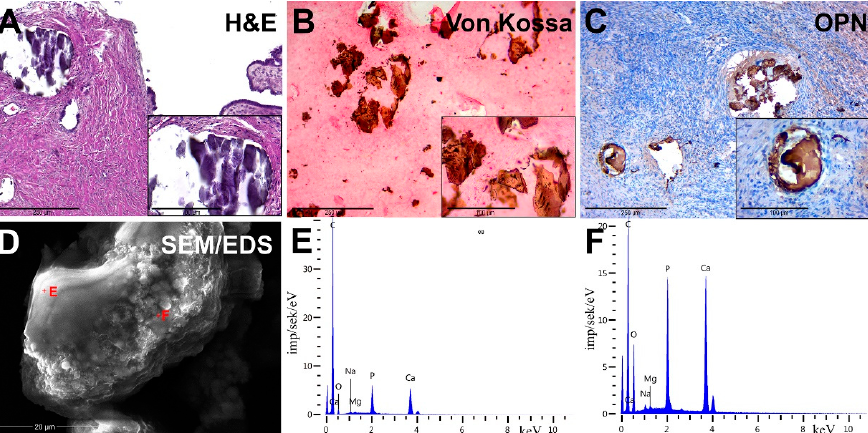
Figure 2. Pathological OC biominerals. ( A ) staining with hematoxylin–eosin; ( B ) von Kossa staining; ( C ) IHC detection of osteopontin (OPN); ( D ) Scanning Electron Microscopy (SEM) with energy-dispersive X-ray spectroscopy (EDX), analysis points are marked by red crosses; ( E , F ) EDX spectra of ovarian cancer calcifications.